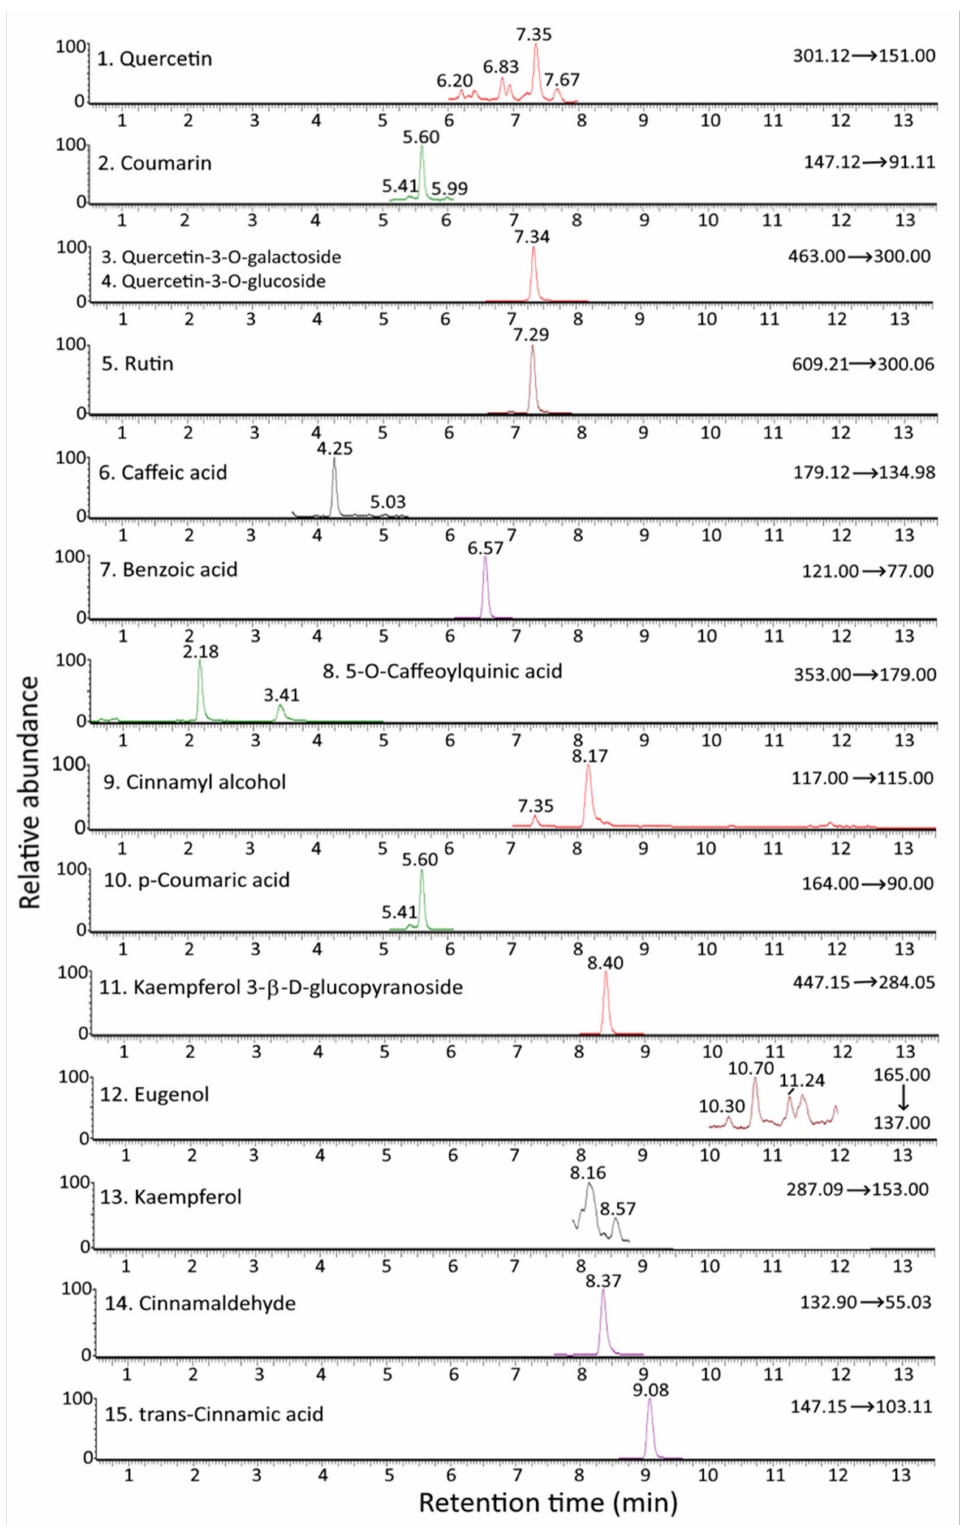
Figure 2. UPLC-MS/MS chromatograms of cinnamaldehyde and various bioactive compounds in C. osmophloeum leaves as detected by MRM